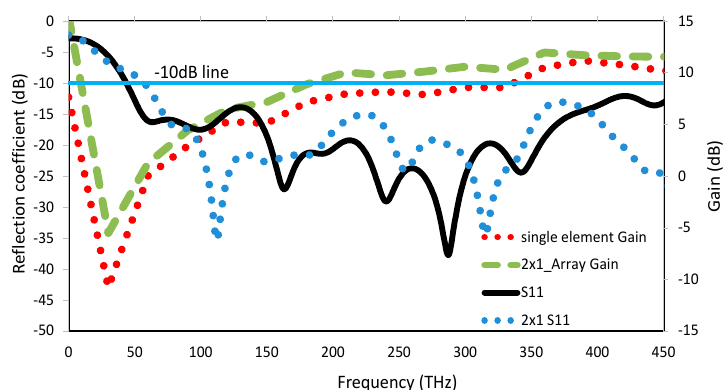
Figure 13. S 11 and gain comparison of the single element and 2 × 1 array.